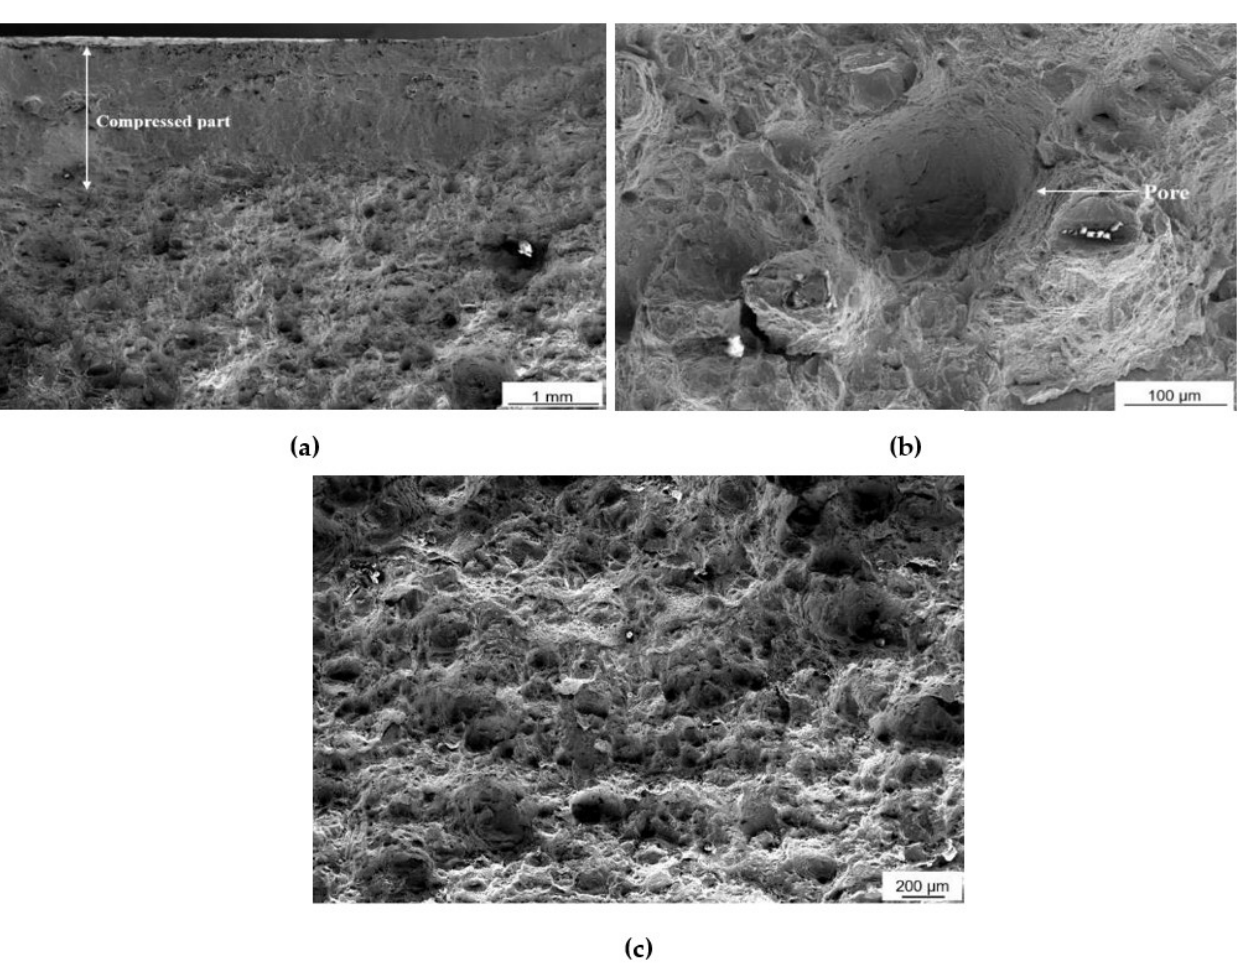
Figure 3. Images portraying the fractured surface of the notched sample ( a ) Compressed part after fracture, showing brittle behaviour. ( b , c ) Characteristics of ductile behaviour.